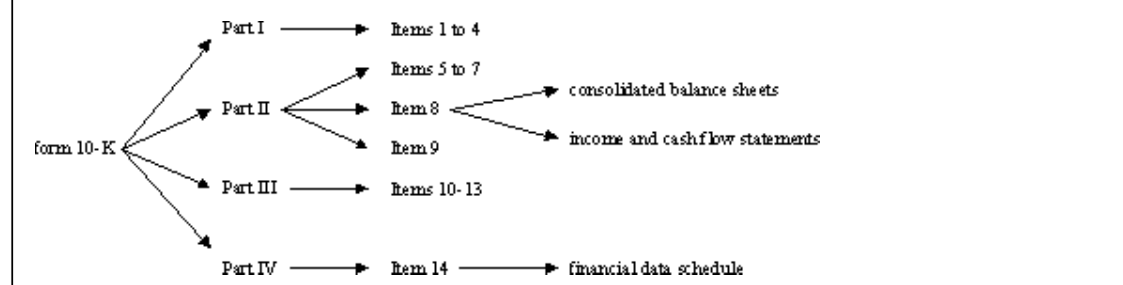
Figure 1 Overview of form 10-K